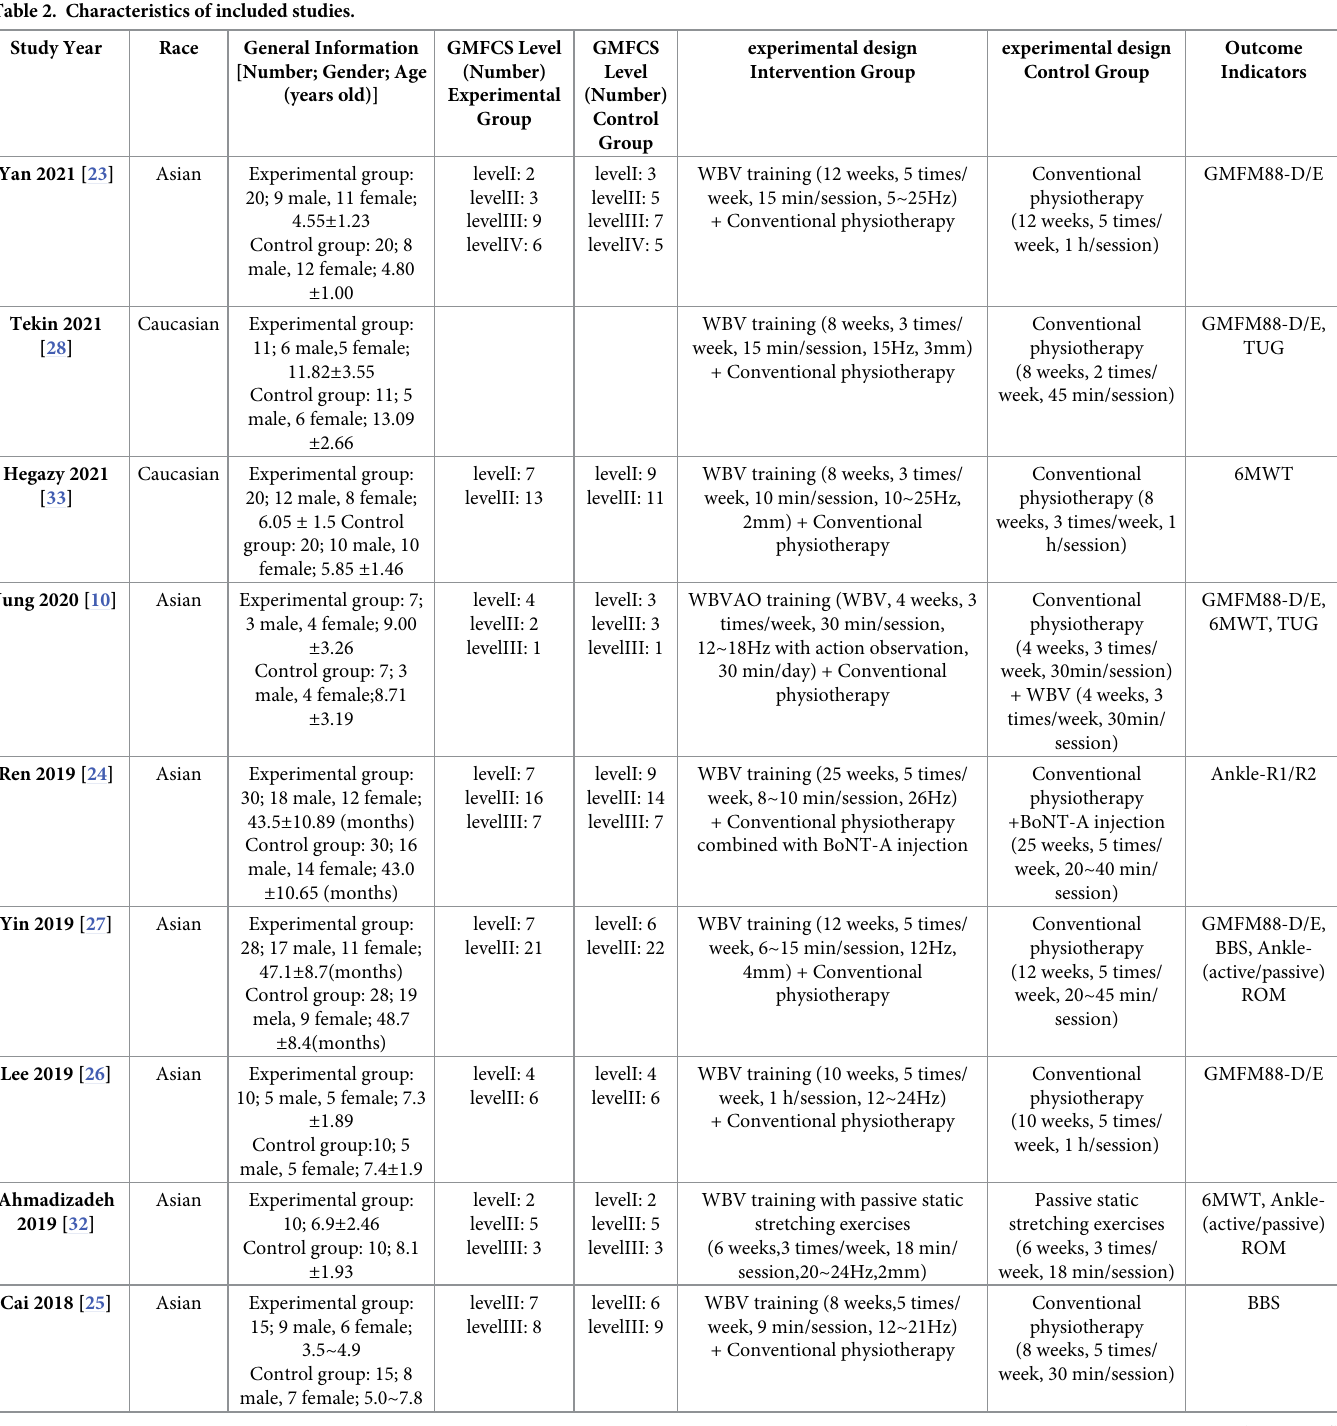
Table 2. Characteristics of included